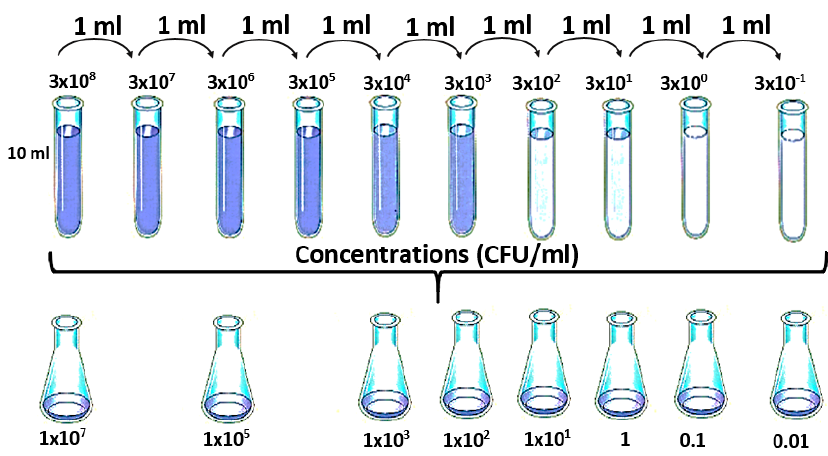
Figure 2. Procedure carried out for the dilution of the control of E. coli .